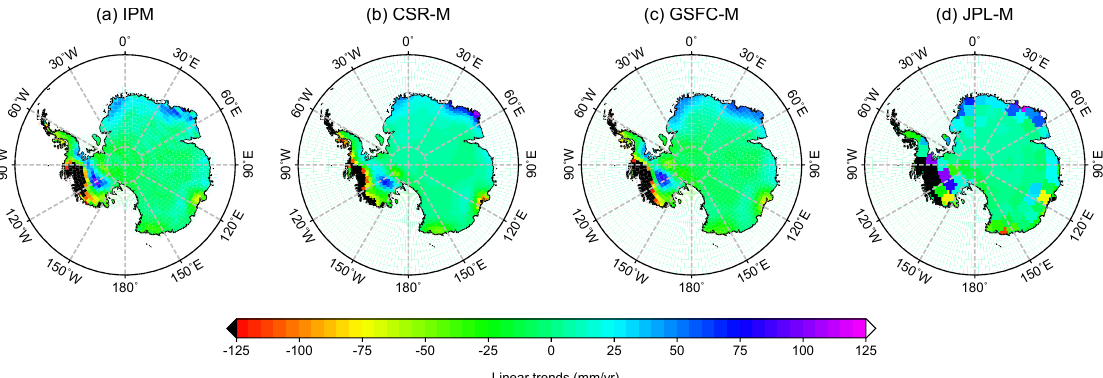
Figure 5. Linear trends derived from the mass changes referring to the best fit of the series considering constant, linear trend, annual, semi-annual, and 161-days components regarding the period from January 2003 to December 2015. Panels ( a – d ) show results based on improved point-mass (IPM) and mascon solutions from CSR (CSR-M), GSFC (GSFC-M), and JPL (JPL-M) , respectively. The GRACE monthly solutions can be better used at a basin- or region-level time series